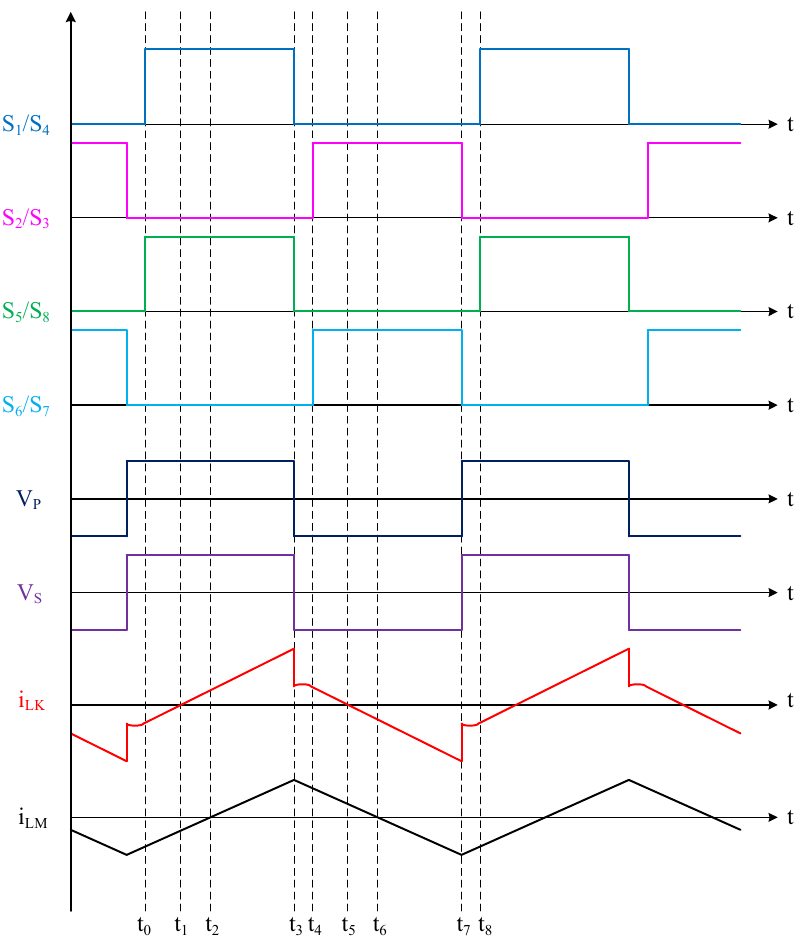
Figure 5. Theoretical waveforms of the proposed control strategy for the DAB converter in PWM mode under light load conditions.